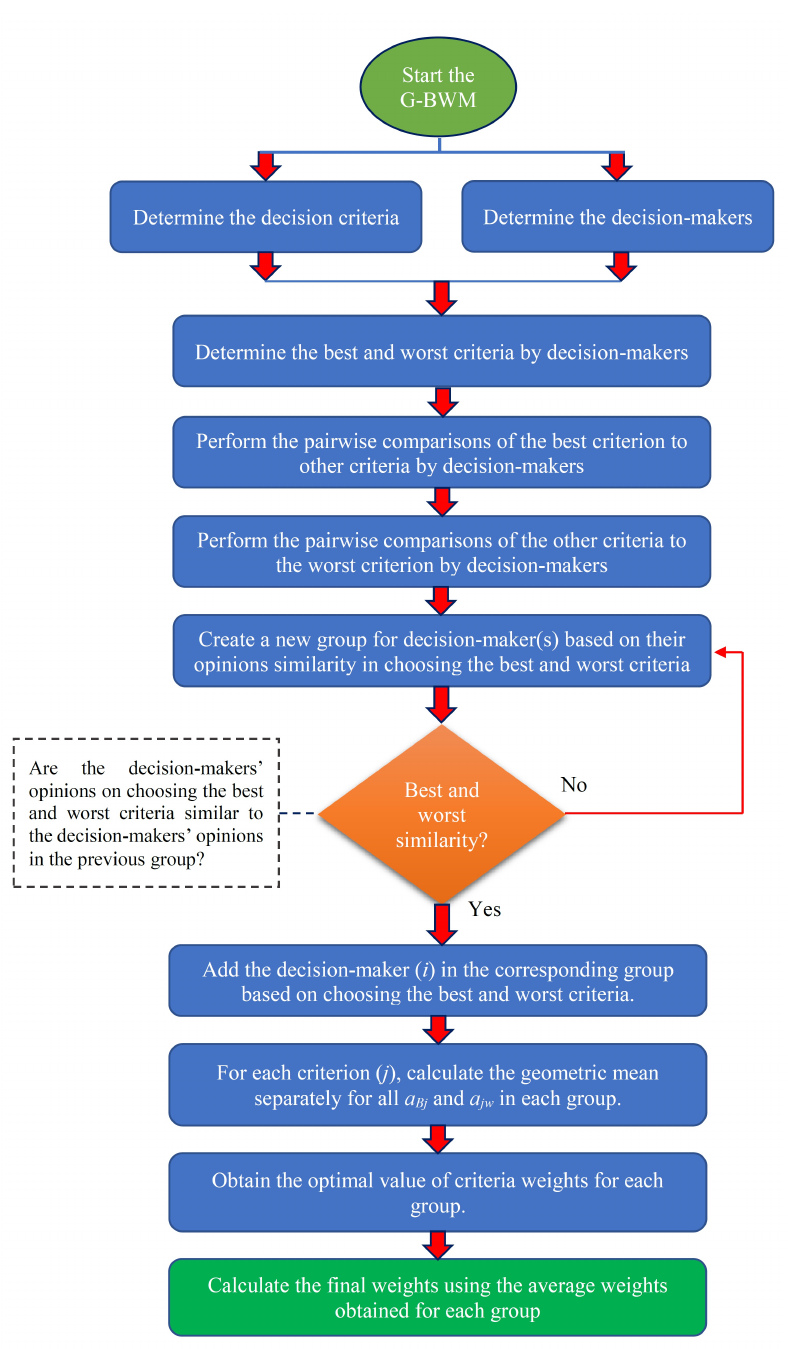
Figure 3. Flowchart of the proposed